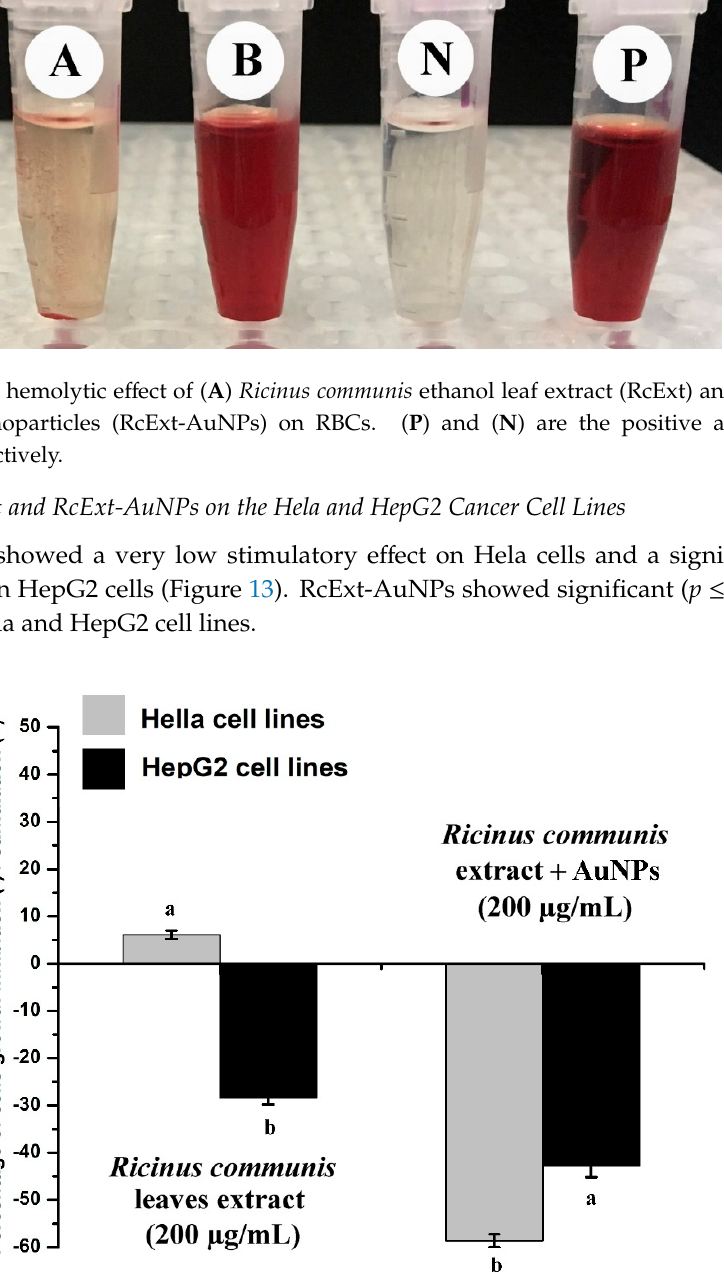
Figure 13. Effect of Ricinus communis leaf extract (RcExt) and gold nanoparticles fabricated with extract (RcExt-AuNPs) on Hela and HepG2 cell line growth. All data are represented as mean ± standard deviation (indicated as error bars) from three determinations. Bars with letters in each group indicate a significant ( p ≤ 0.05) difference among the treatments.